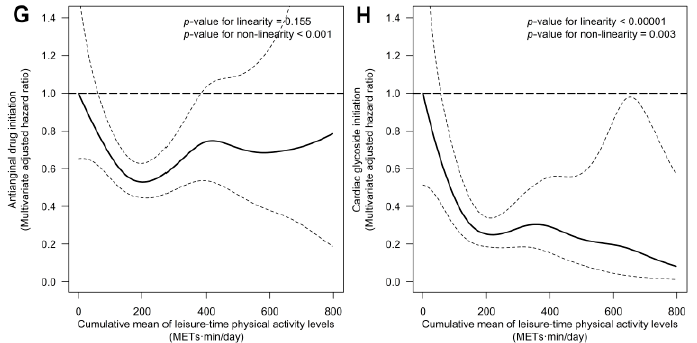
Figure 3. Association between long-term levels of physical activity and the risk of initiating glucose-lowering ( A ), antihypertensive ( B ), statin ( C ), fibrate ( D ), antiplatelet ( E ), vitamin K epoxide reductase inhibitors ( F ), antianginal ( G ), and cardiac glycoside ( H ) therapies. Cox proportional hazards regression models with cubic splines were stratified by sex, recruitment site, and educational level, and adjusted for: age, diabetes, hypertension, hypercholesterolemia, hypertriglyceridemia, smoking habit, body mass index, alcohol consumption, energy intake, adherence to a MedDiet, and PREDIMED intervention group. We substituted diabetes for fasting glucose in the analysis on glucose-lowering therapy initiation, hypertension for systolic blood pressure in the analysis on antihypertensive therapy initiation, hypercholesterolemia for total cholesterol in the analysis on statin initiation, and hypertriglyceridemia for triglycerides in the analysis on fibrate initiation. We used robust variance estimators to account for intra-cluster correlations.